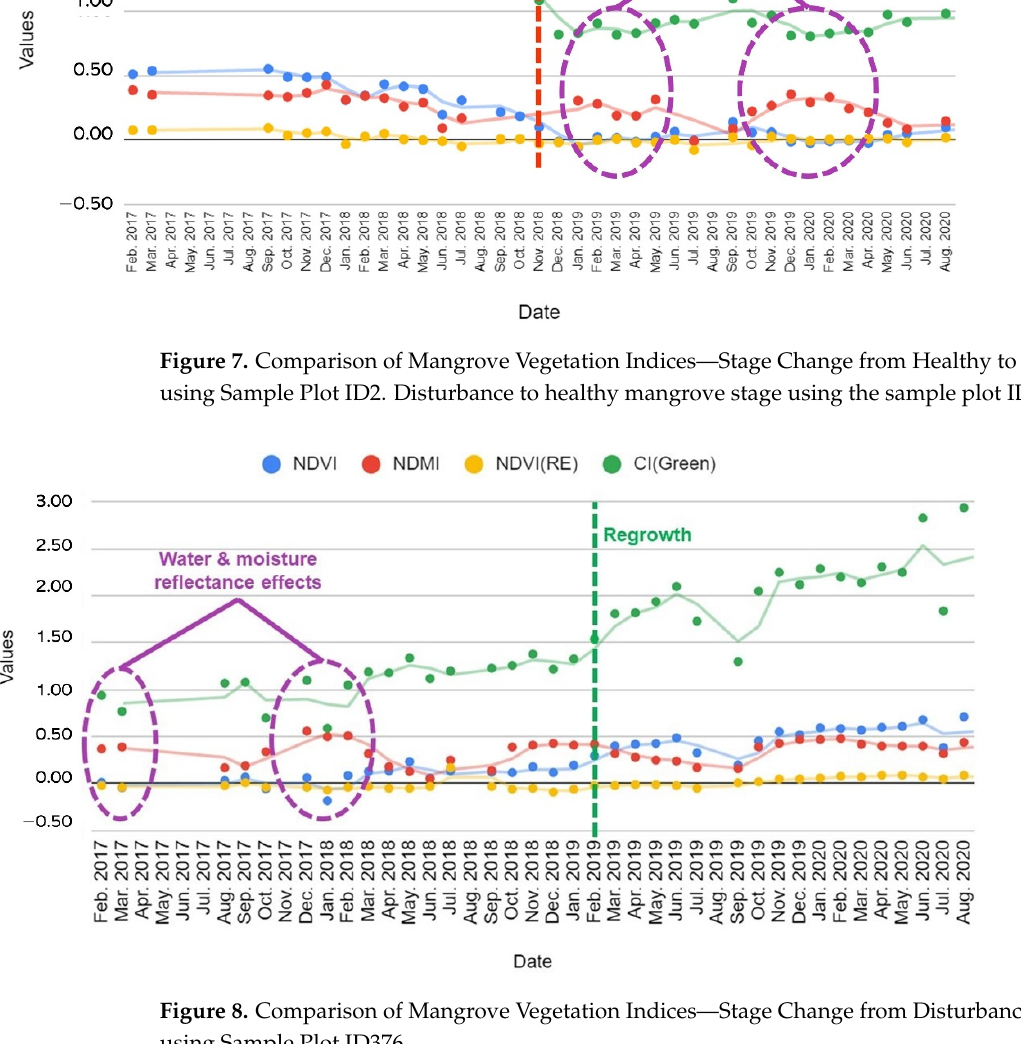
Figure 8. Comparison of Mangrove Vegetation Indices—Stage Change from Disturbance to Healthy using Sample Plot ID376.